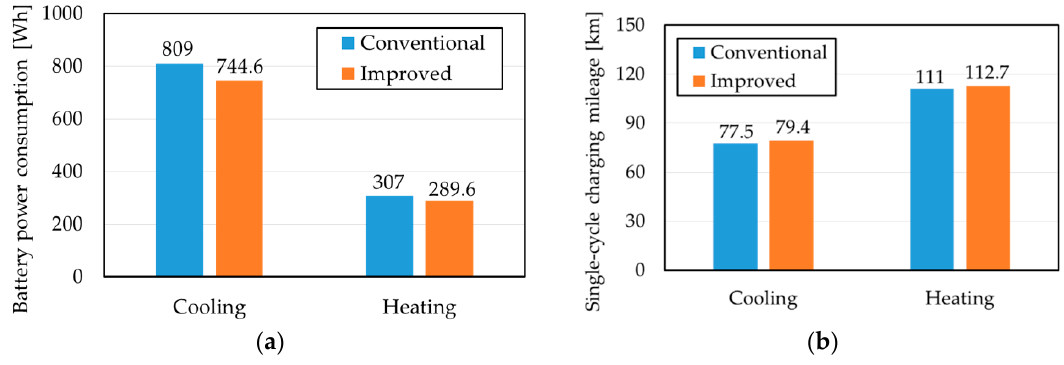
Figure 20. ( a ) Battery power consumption and ( b ) mileage resulting from one charge cycle with conventional and proposed headliners under cooling and heating conditions.